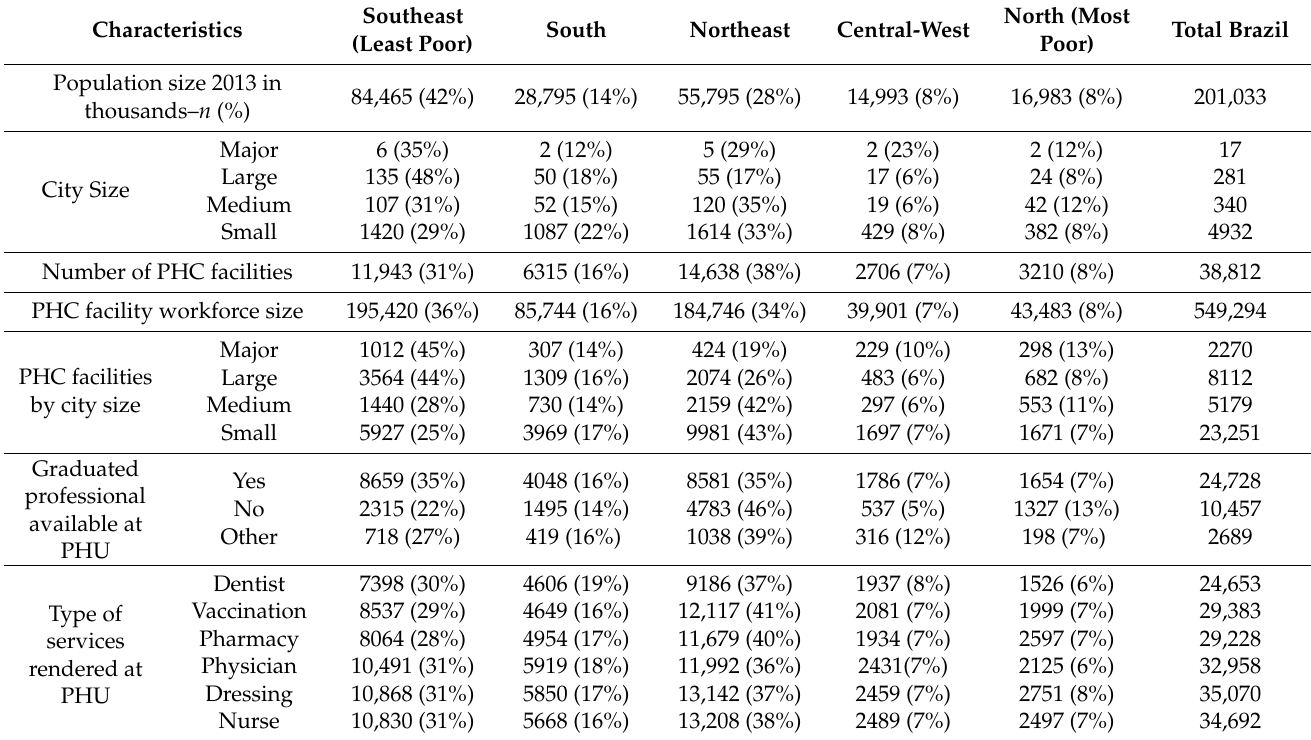
Table 2. Comparison of five regions in Brazil in terms of demographics, number and distribution of primary health care facilities in 2012.